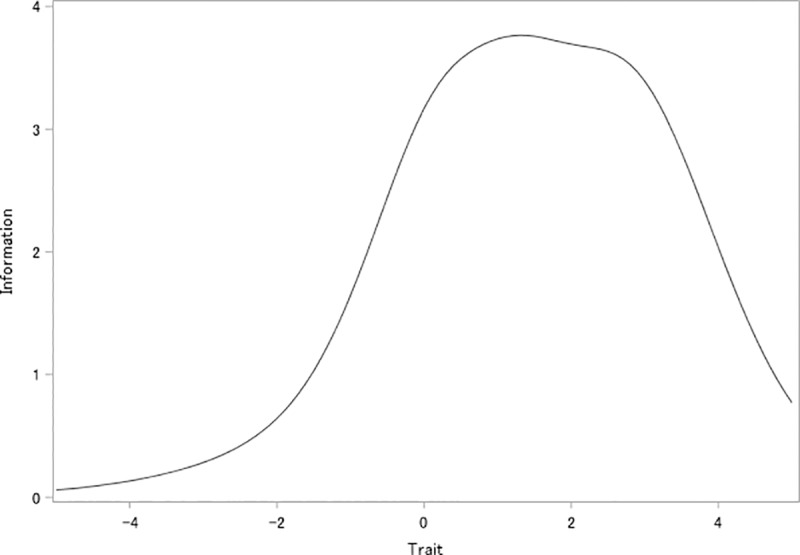
Item information curve for each item of K6 among hospital nurses in Vietnam.The vertical axis indicates the latent trait of psychological distress.